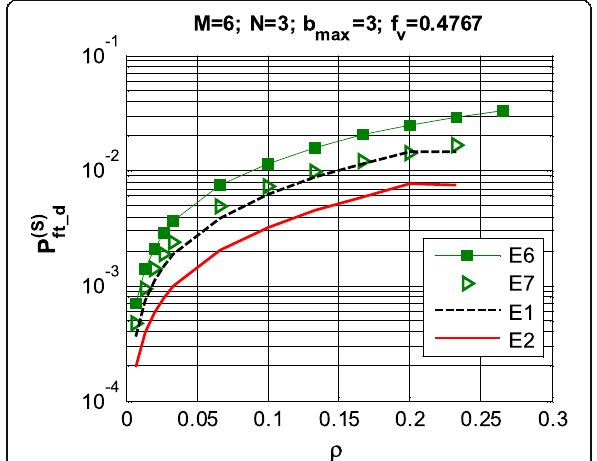
Fig. 8 Forced termination probability of data traffic as a function of ρ , for f v =